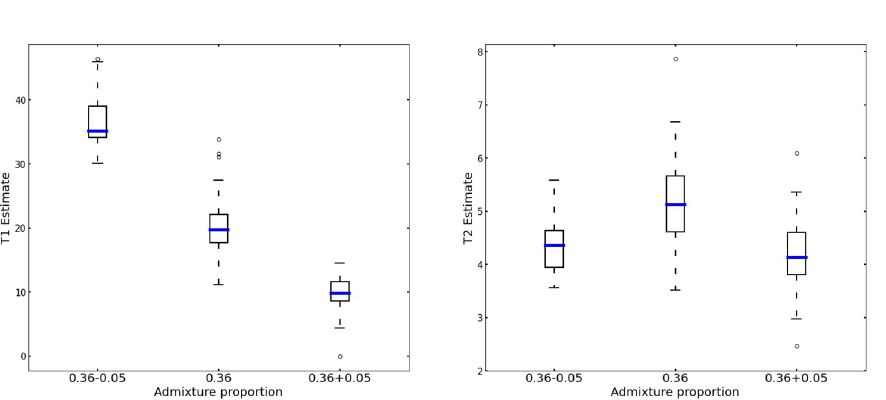
Fig 6. Effect of admixture proportion misspecification on the estimated values of T 1 and T 2 . Admixture proportion misspecification has a strong effect on the estimates of time T 1 between pulses of admixture. Estimates of the time T 2 of the most recent admixture pulse remain